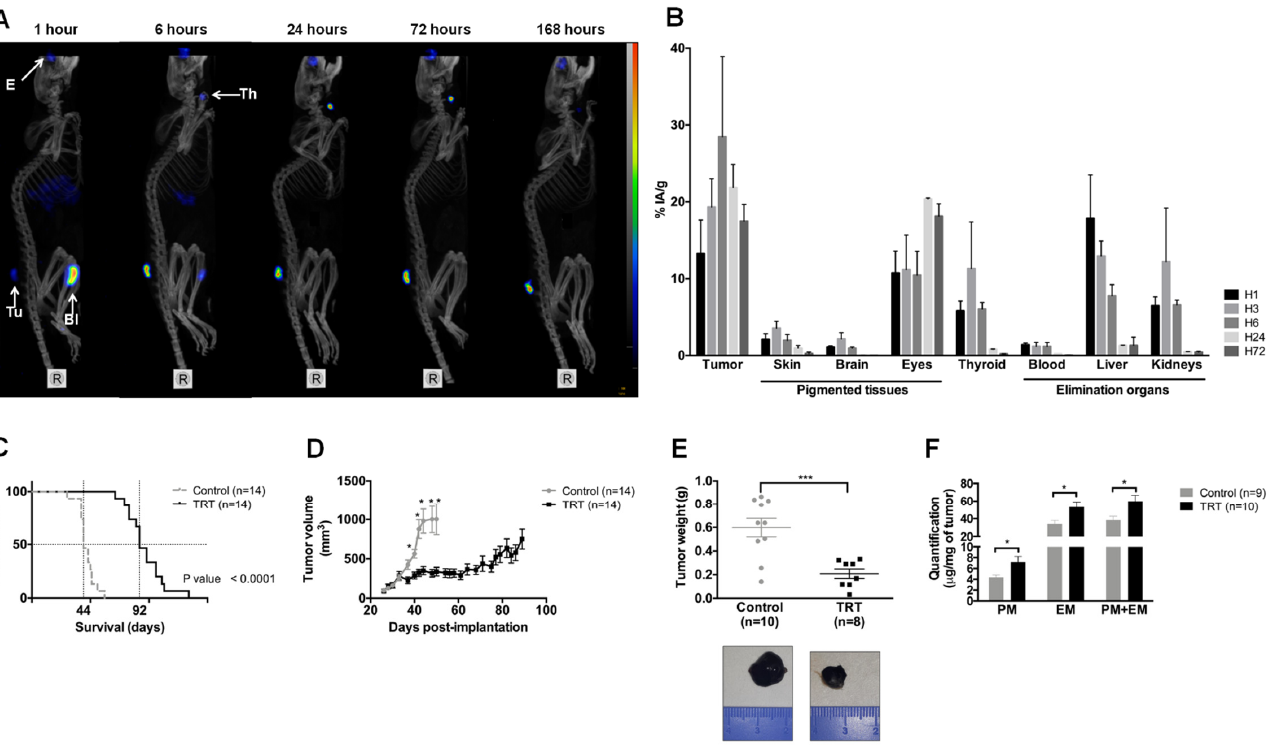
Figure 3. [ 131 I]ICF01012 biodistribution and efficiency in an NRAS-mutant murine model. Results are presented as mean +/ − SD ( D , F ) and as median, 1st quartile, and 3rd quartile ( E ). ( A ) Maximum intensity projection from SPECT-CT imaging of the same mouse from 1 h post-injection to 168 h shows tumor (Tu), eyes (E), thyroid (Th), and bladder (Bl) fixation of [ 131 I]ICF01012. ( B ) Biodistribution of [ 131 I]ICF01012, expressed as the percentage of injected activity/gram, was determined for each timepoint and each non-target organ by activity count (n = 3 mice per timepoint). ( C , D ) Survival curve ( C ) and tumor growth ( D ) were determined using 14 animals for each group. ( E ) Tumor weight for 10 control mice and eight TRT-treated mice, sacrificed 10 days after treatment, illustrated by 2 tumors representative of observed differences between control and TRT tumors. ( F ) Pheomelanin (PM) and eumelanin (EM) were quantified for nine control tumors and 10 TRT tumors. (* p < 0.05,*** p < 0.001).